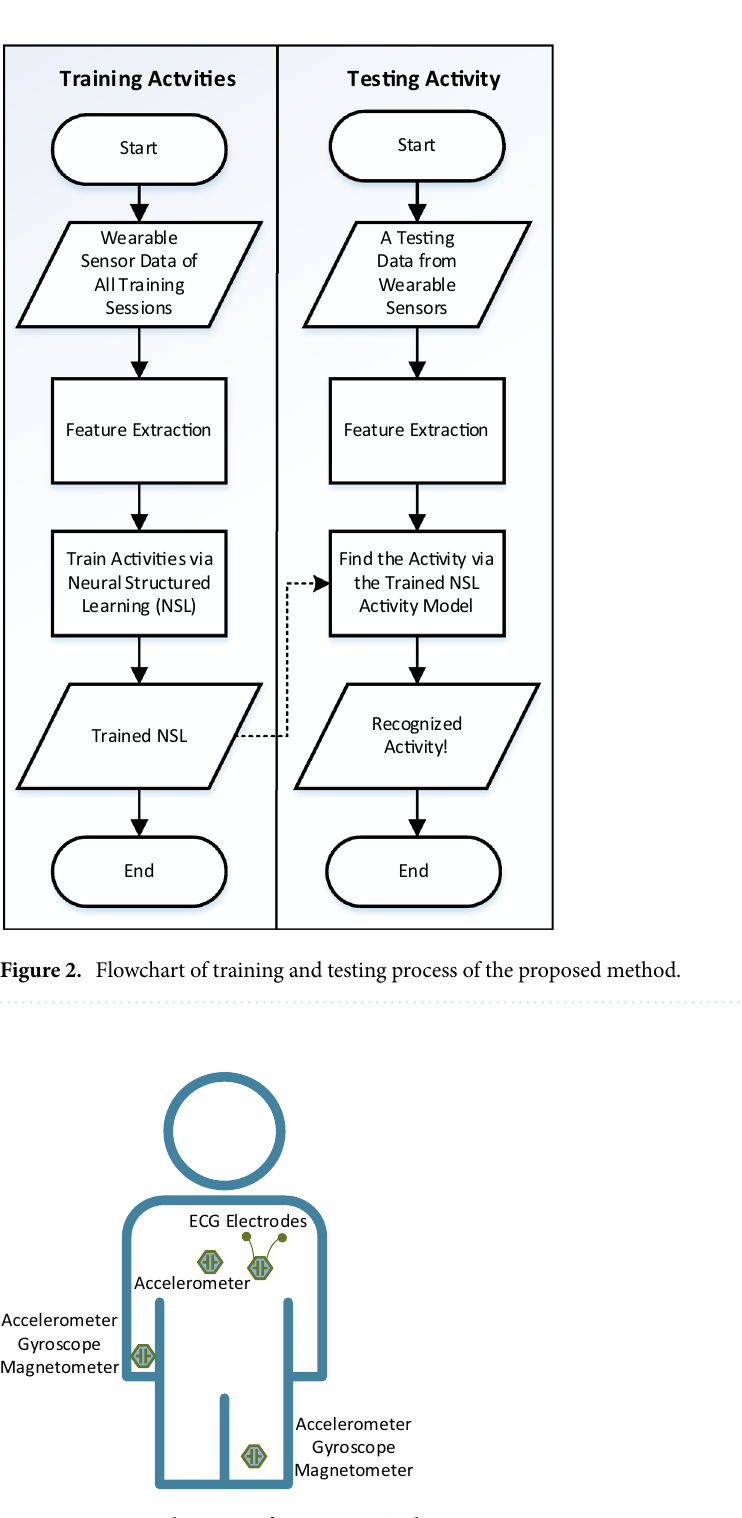
Figure 3. Sensor placements for MHEALTH